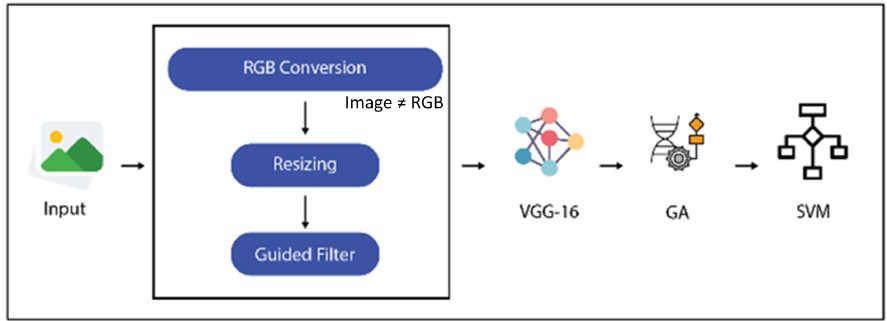
Figure 1. Proposed